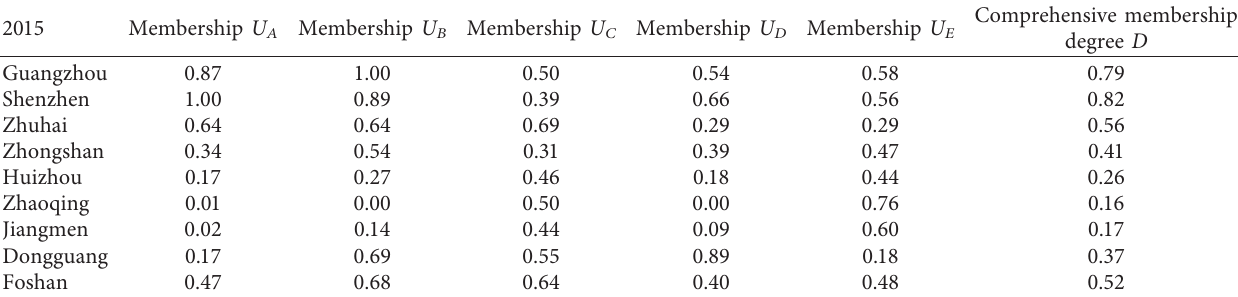
Table 14: First-level membership of the happiness index of nine cities in the Pearl River Delta in 2015. 2015